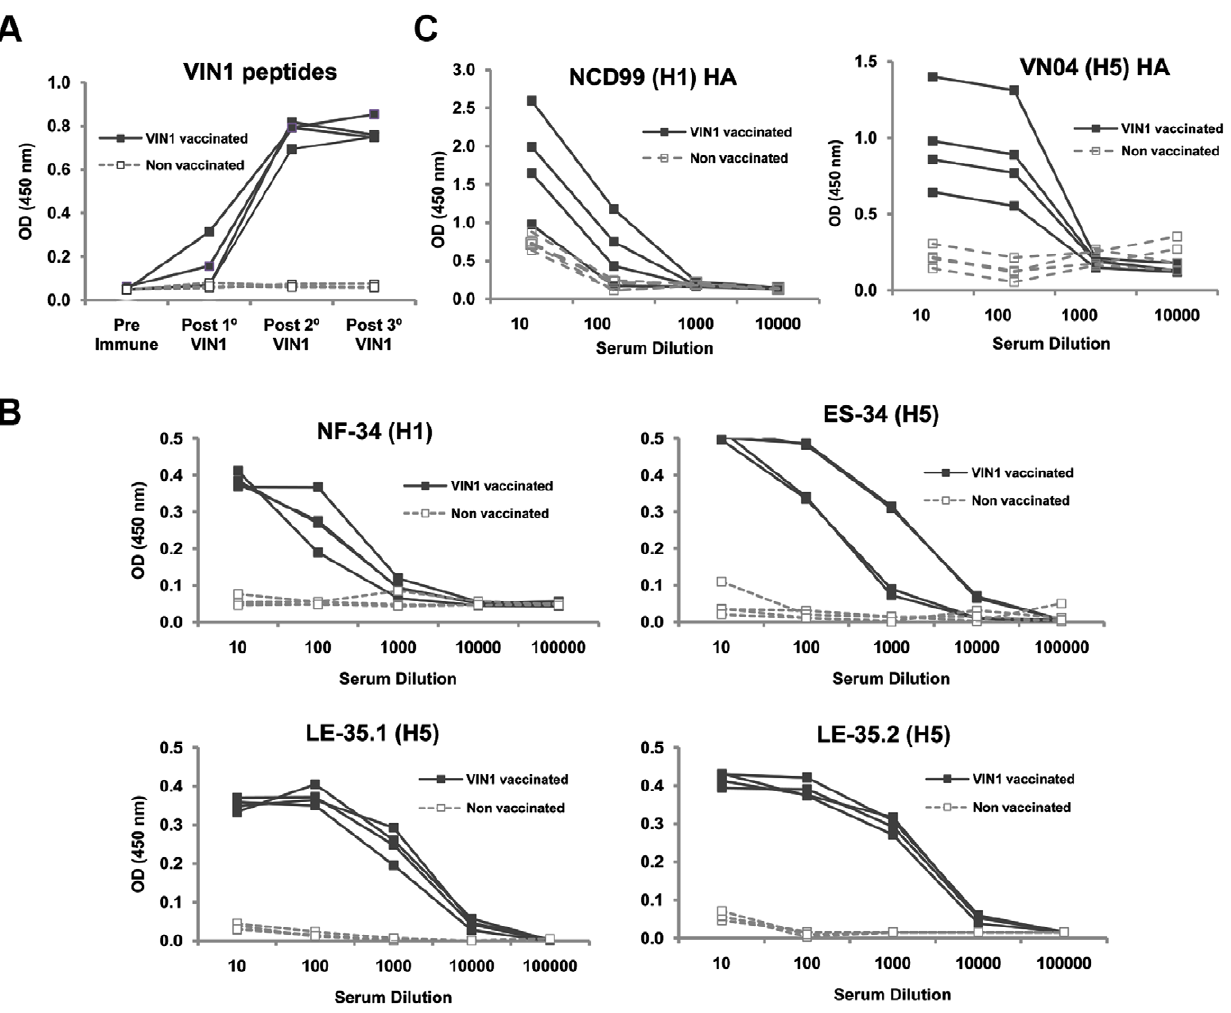
Figure 1. VIN1-peptide cocktail acts as a potent immunogen and the elicited sera reacts with different hemagglutinin subtypes and against VIN1-peptides. (A) Sera from individuals were obtained 15 days after each immunization and were tested for binding to a mixture of the VIN1-peptides (serum dilution 1:100) by ELISA. (B) Sera from individual pigs were obtained 15 days after the third immunization and were serially diluted and tested for binding to each single peptide by ELISA and (C) Sera described in B) were tested for binding to H5- or H1- recombinant hemagglutinin by ELISA.